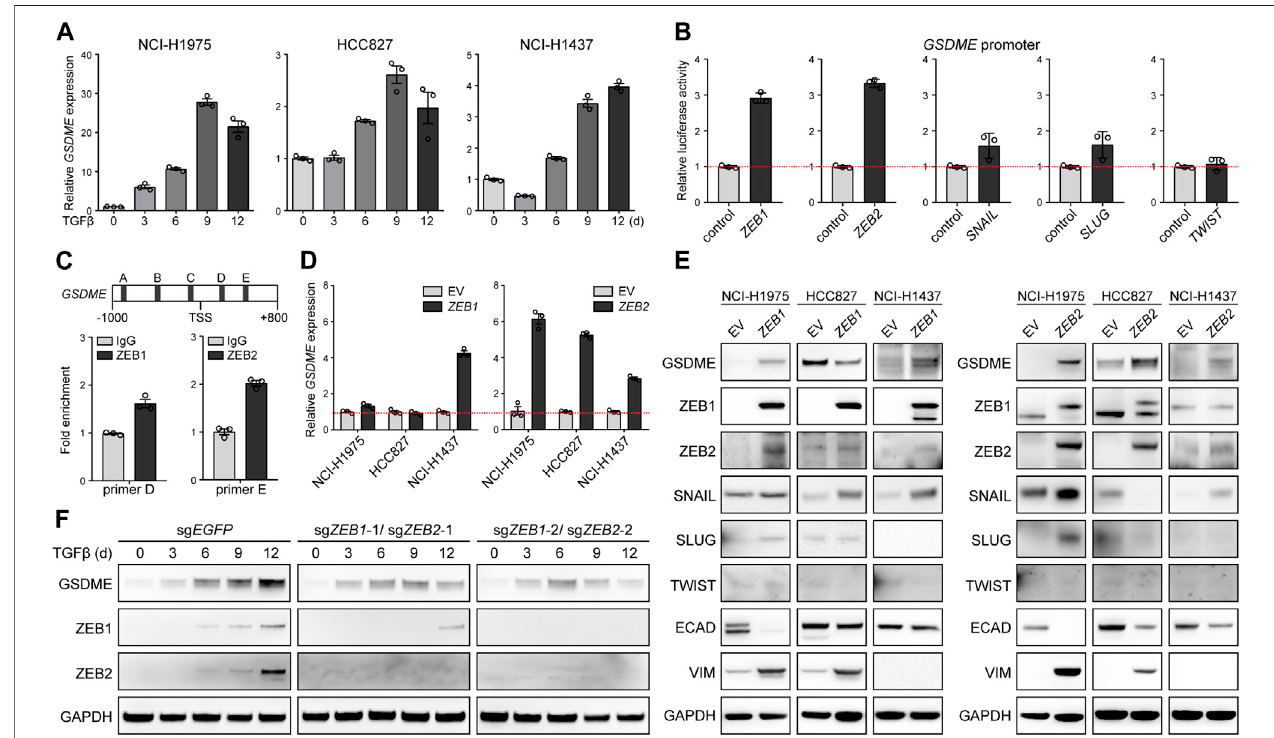
FIGURE 3 | Direct induction of GSDME transcription by the EMT activator ZEB1/2. (A) Three indicated lung cancer cell lines were treated with TGF β (5 ng/ μ l) at a time course manner and analyzed by qPCR for GSDME gene expression. Data are means ± SEM pooled from three independent experiments. (B) Five core EMT-TFs ( ZEB1 , ZEB2 , SNAIL , SLUG , and TWIST ) were co-transfected with GSDME promoter fused with dual luciferase reporter system and luciferase activity was assayed against the vector control. Data are means ± SEM pooled from three independent experiments. (C) ZEB1 or ZEB2 was overexpressed in NCI-H1975 cells and ChIP-qPCR analysis was performed with primer sets fl anking fi ve predicted ZEB1/2-binding consensus sequence proximal to the GSDME TSS (transcription start site). ZEB1 and ZEB2 wasobservedtobind to (D,E) locus at the GSDME promoterregion, respectively. Dataare means ± SEMpooled from three independent experiments. (D) EMT-TFs ZEB1 or ZEB2 was overexpressed in three indicated lung cancer cell lines and analyzed by qPCR for GSDME gene expression. Data are means ± SEM pooled from three independent experiments. (E) EMT-TFs ZEB1 or ZEB2 was overexpressed in three indicated lung cancer cell lines and analyzed by Western blot for GSDME protein expression. EV, empty vector. (F) ZEB1 and ZEB2 were simultaneously knocked out in HCC827 cells using the CRISPR-Cas9 system. Cells were treated with TGF β (5 ng/ μ l) at a time course manner and analyzed by Western blot for GSDME protein expression.